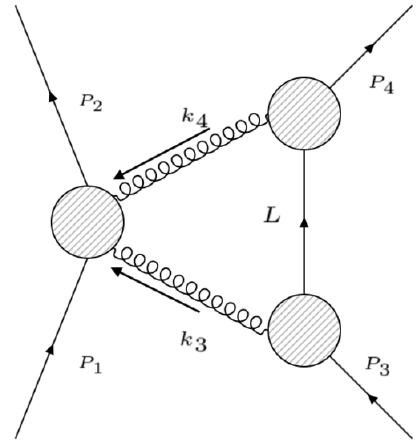
Figure 3 . The triangle diagram used to compute the leading singularity, corresponding to the b - topology. The a -topology is obtained by re(cid:13)ection, i.e. by appropriately exchanging the external